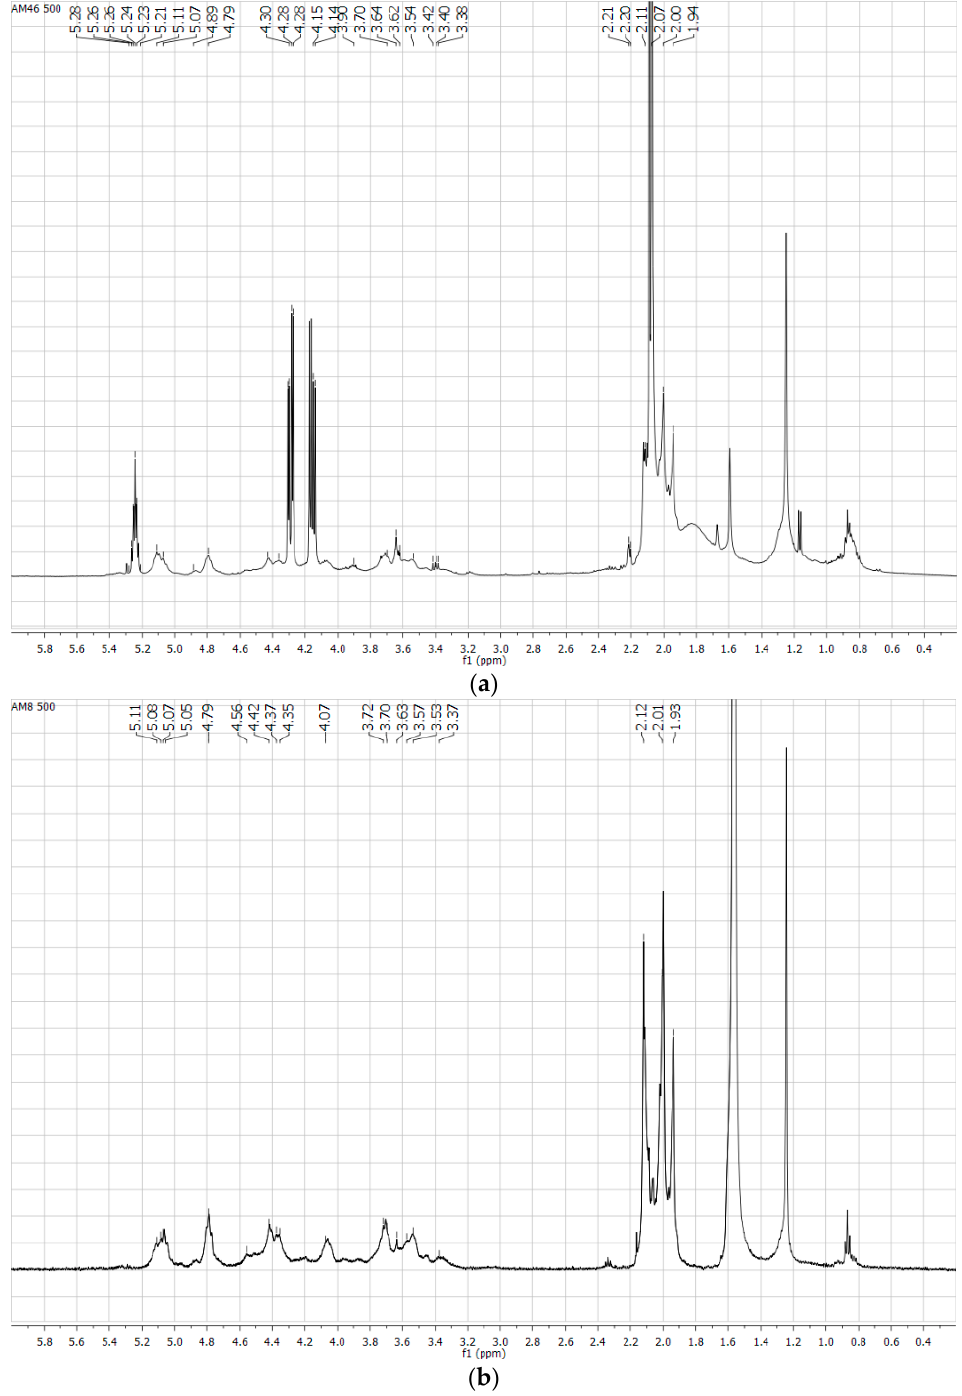
Figure 7. 1 H-NMR spectrum of butts before ( a ) and after ( b ) being submitted to the cleaning ex- tractions.